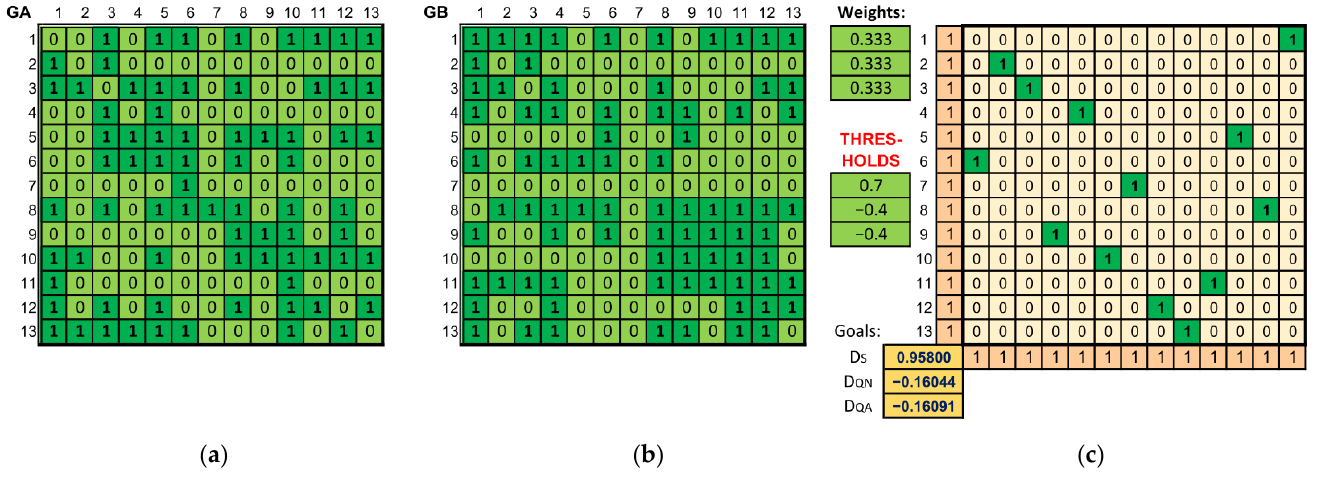
Figure 7. Comparison of L. van Beethoven’s Für Elise and Nocturne Op. 9 by F. Chopin. ( a ) The adjacency matrix of the graph representing the first piece. ( b ) The adjacency matrix of the graph representing the second piece. ( c ) The calculated assignment matrix of vertices from one graph to another (meeting the given threshold criteria) together with the value of individual partial objective functions.